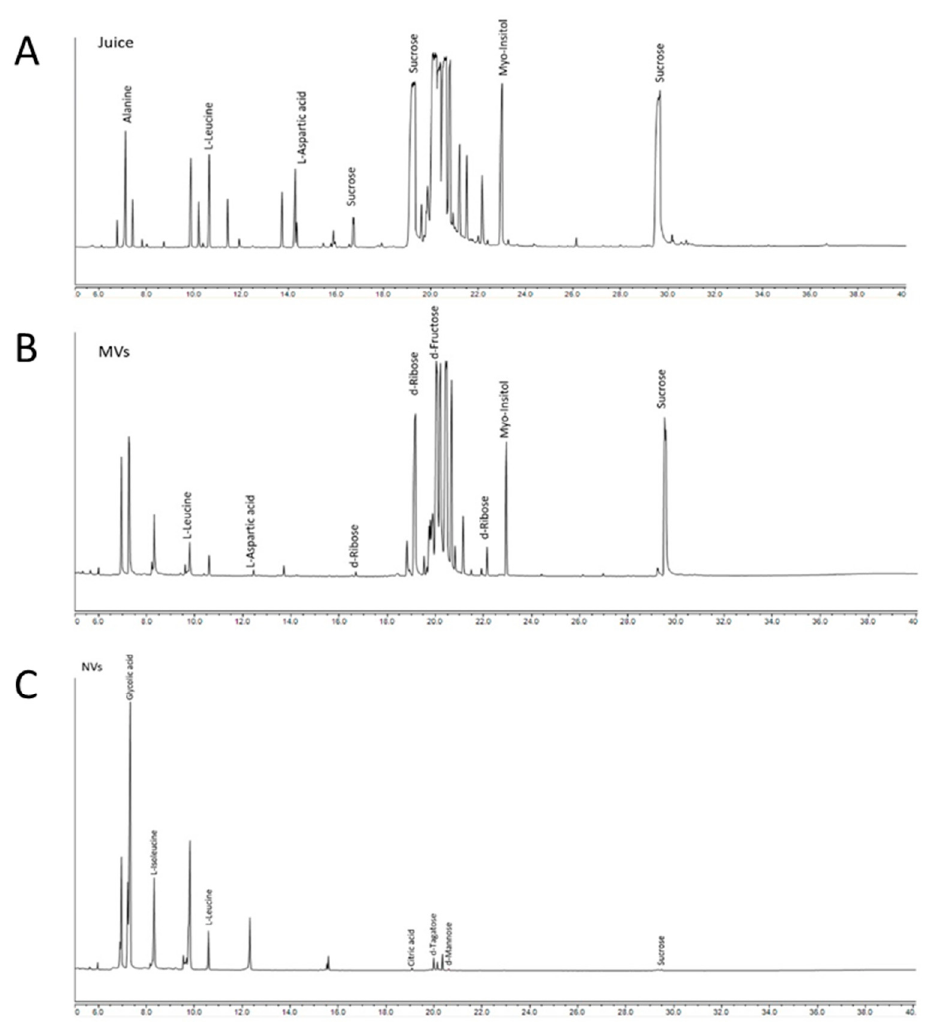
Figure 3. Metabolite profiles of ( A ) whole juice, ( B ) microvesicles and ( C ) nanovesicles isolated from grapefruit and analysed by GC-MS in full scan mode. Chromatograms are showing the most abundant GC-MS peaks and their tentative identifications.